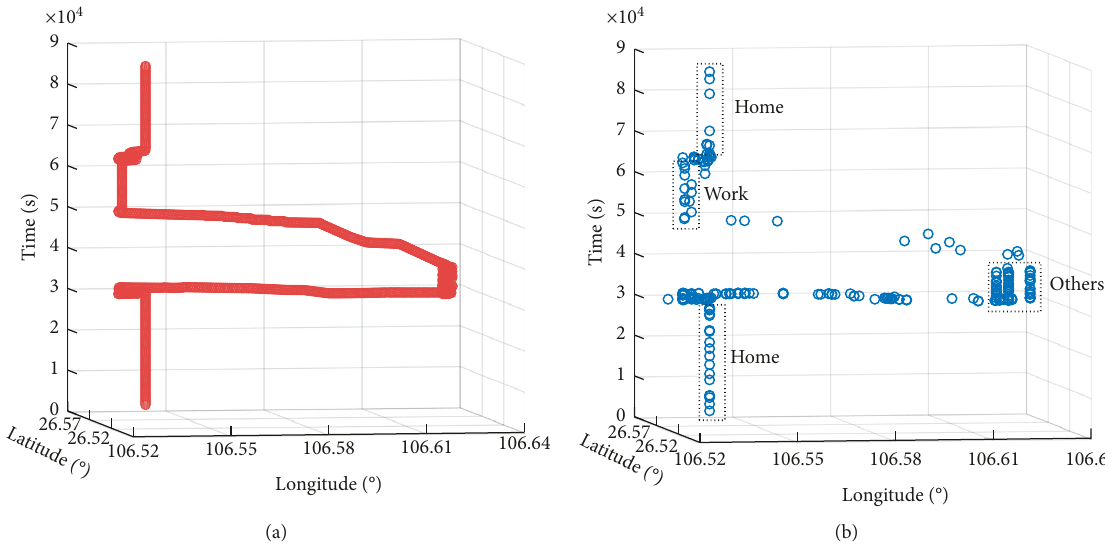
Figure 10: Spatiotemporal distribution of GPS and mobile phone data of a case sample. (a) GPS trajectories. (b) Mobile phone